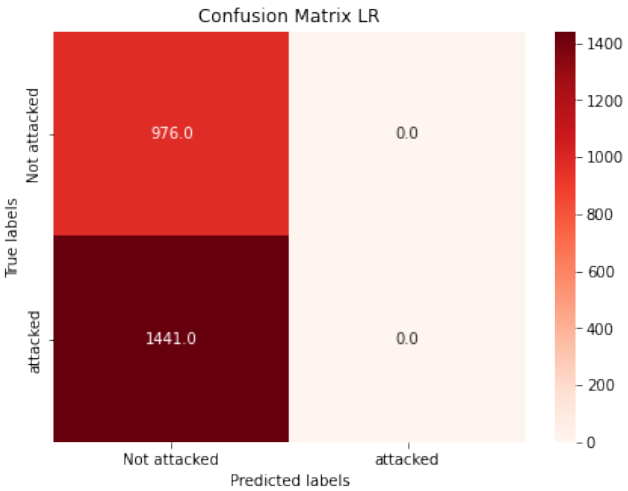
Figure 10. Confusion matrix on prediction of K-nearest neighbors (KNN) classifier.